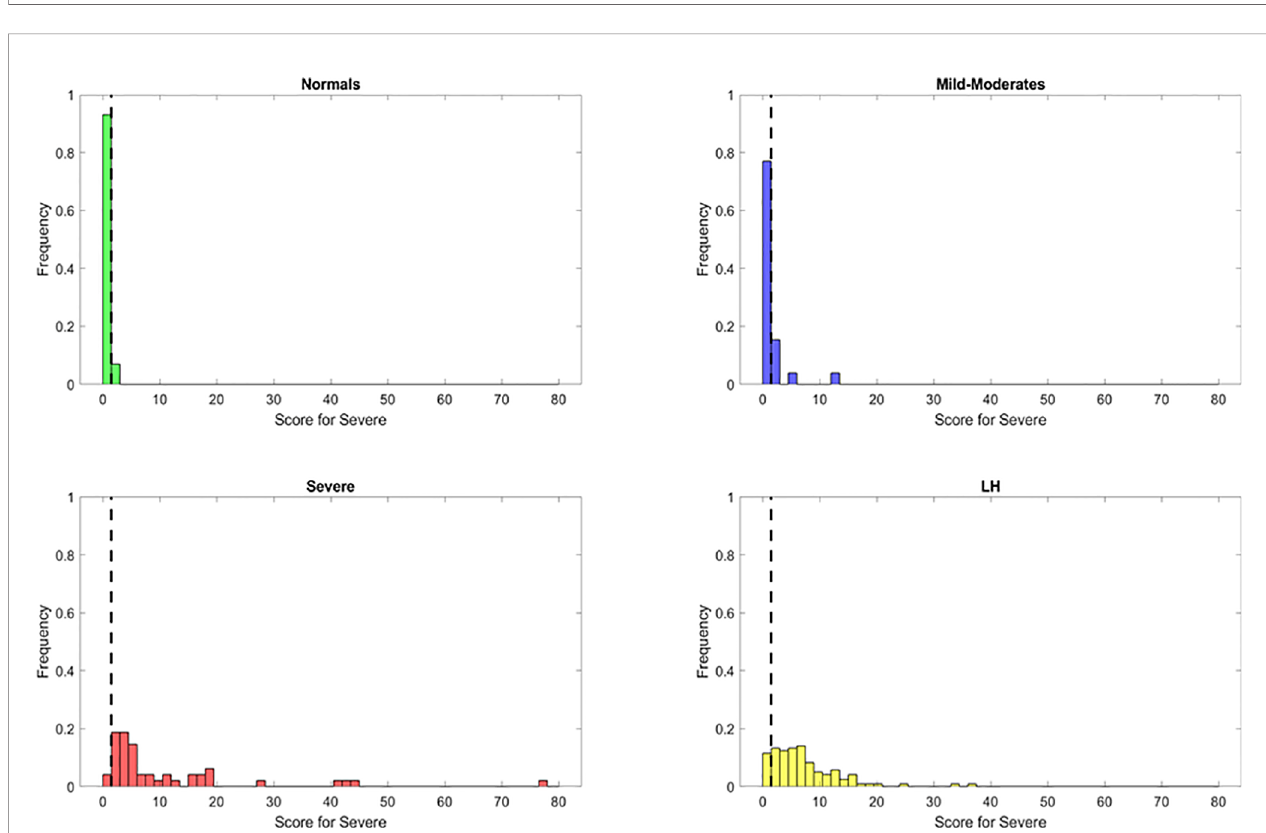
FIGURE 6 | Discrimination ability of the Severe score for the identi fi cation of Severe patients (S1) with reduced or most important features identi fi ed using Random Forest classi fi er. The dots represent the data points, where yellow are PASCs, red-Severe, dark blue-Mild-Moderate and green-healthy control.